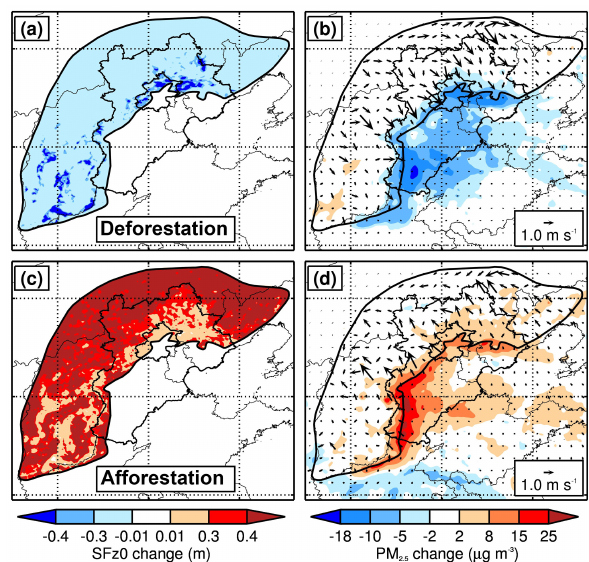
Figure 7. Impacts of complete deforestation/afforestation over Tai- hang and Yanshan Mountains on (a) – (c) SFz0 and (b) – (d) average near-surface PM 2 . 5 mass concentrations from 1 December 2013 to 31 January 2014, along with the wind field change (black